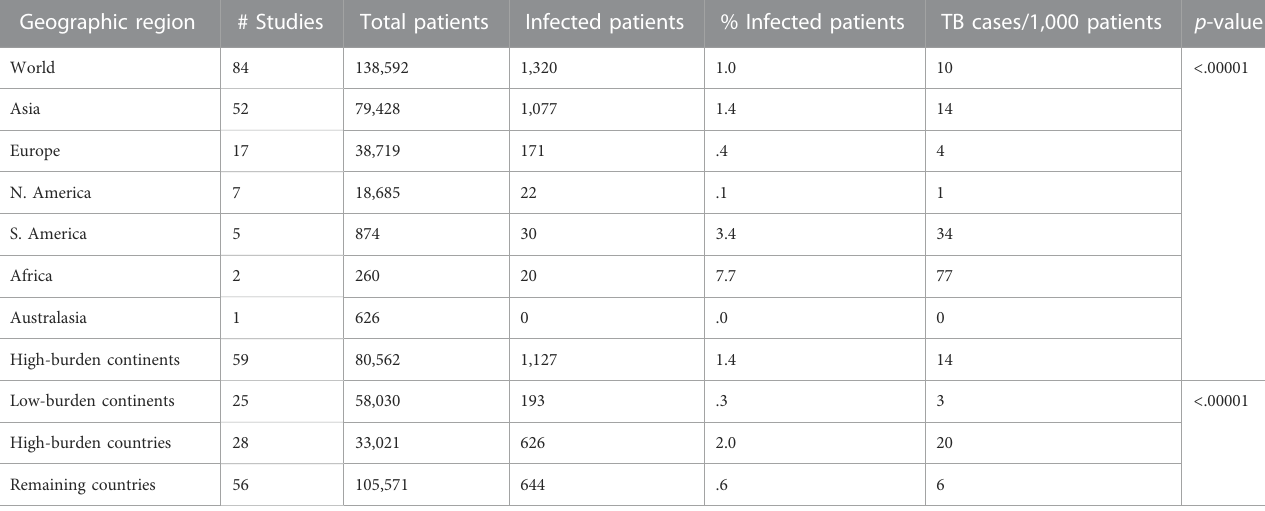
TABLE 1 Interregional differences in the frequency of TB infection in patients receiving TNF α